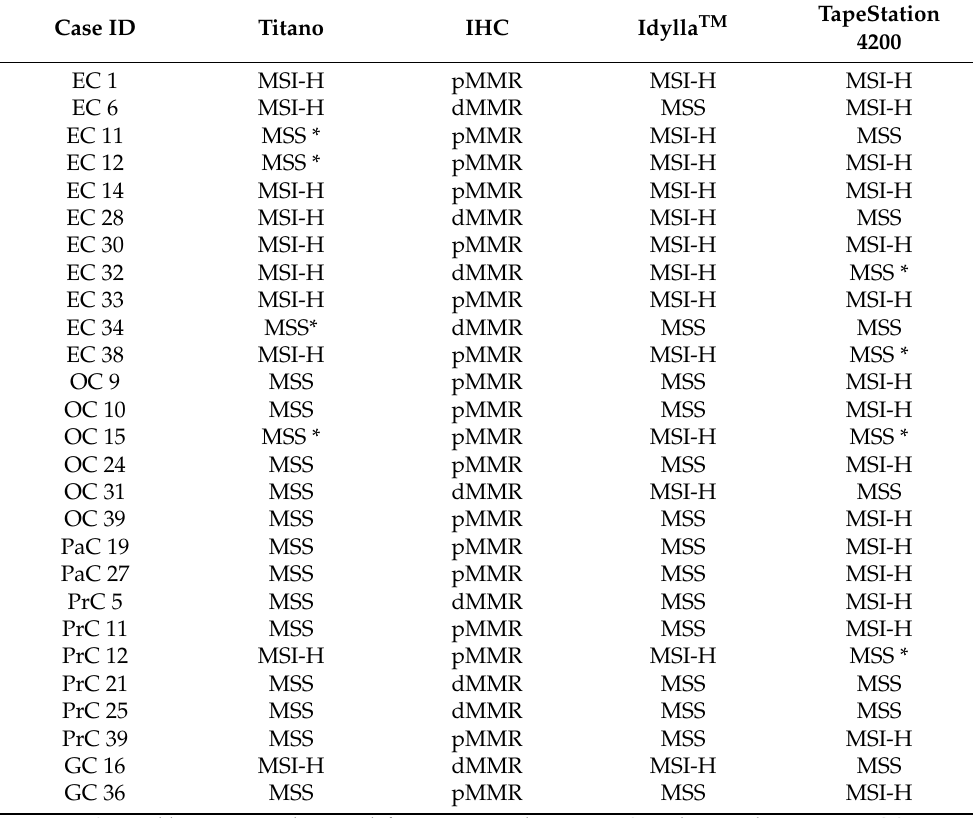
Table 6. Comparative analysis of the discordant